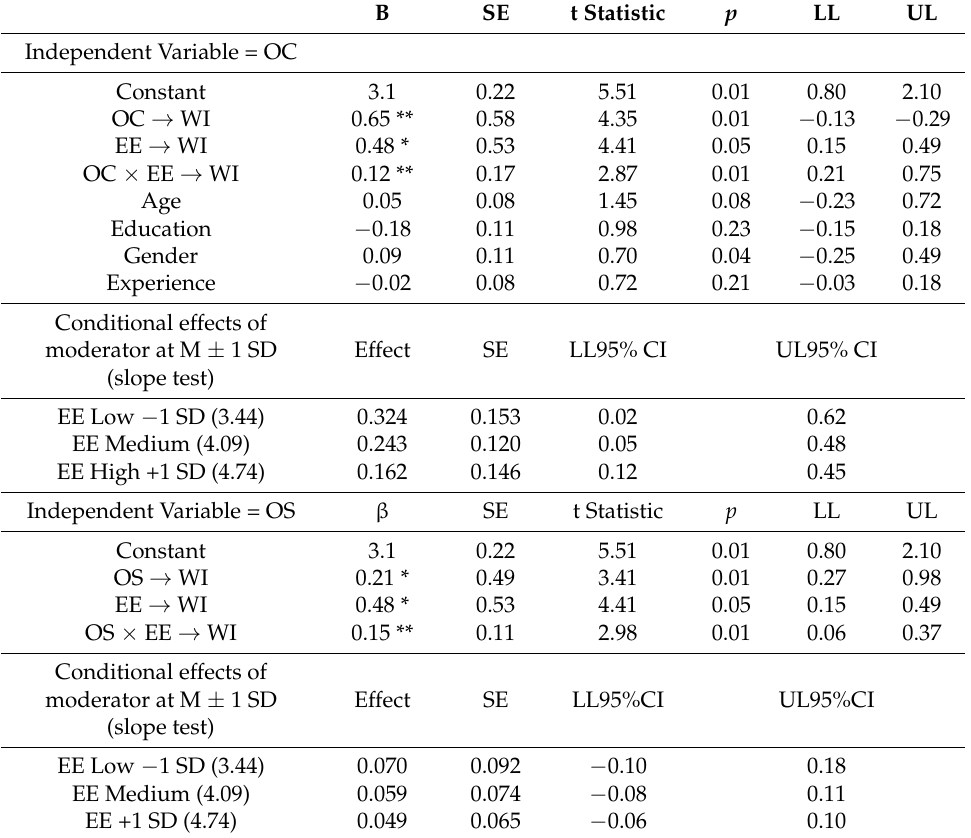
Table 4. Moderation analysis.